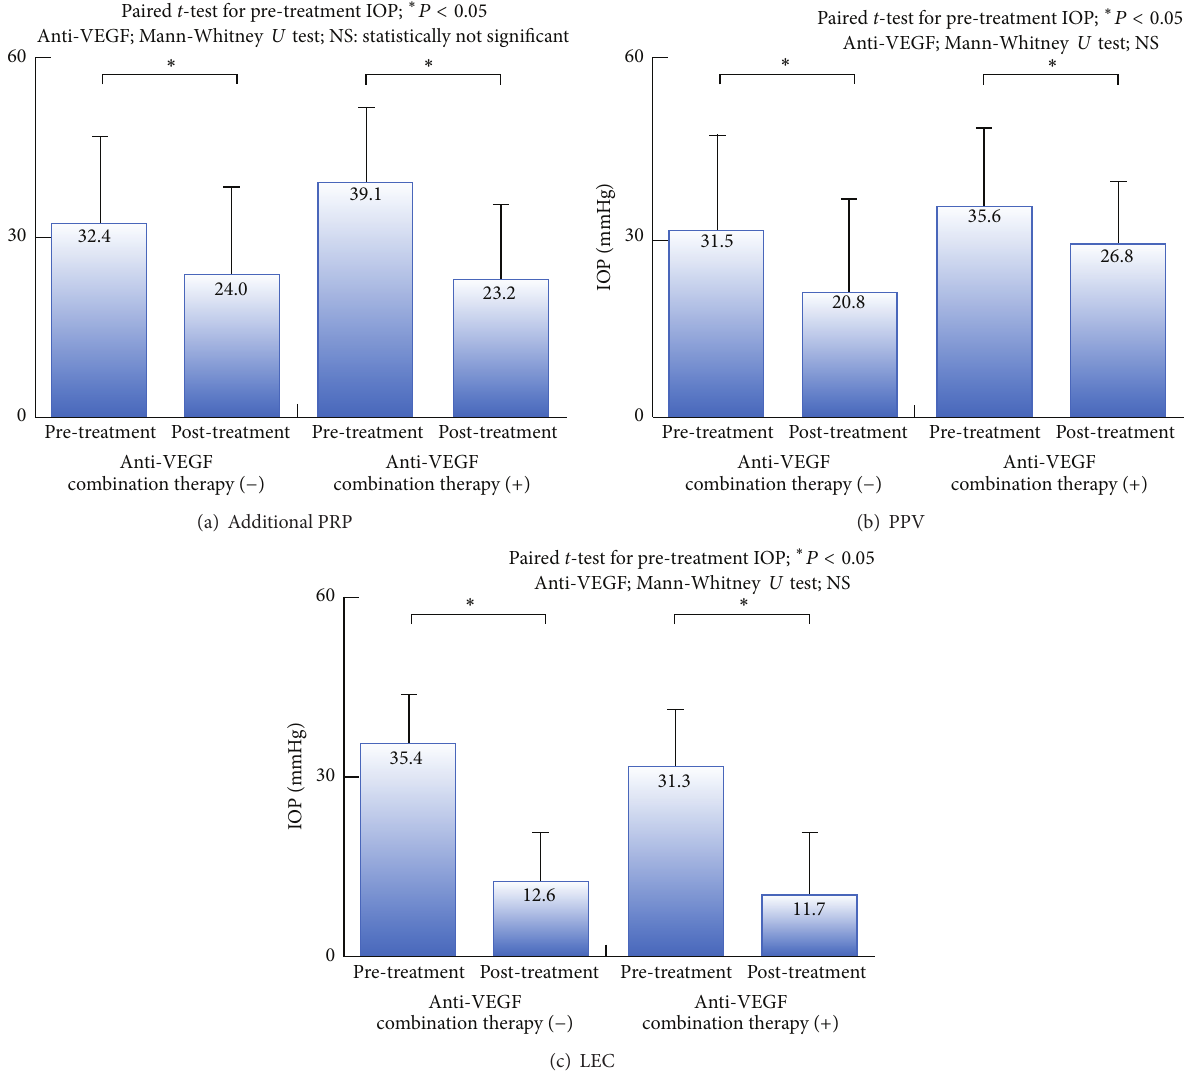
Figure 6: Post-treatment IOP with or without anti-VEGF combination therapy. All treatments with or without anti-VEGF combination therapy had a significant effect on IOP. No significant differences in post-treatment IOP were observed between patients treated with or without anti-VEGF combination